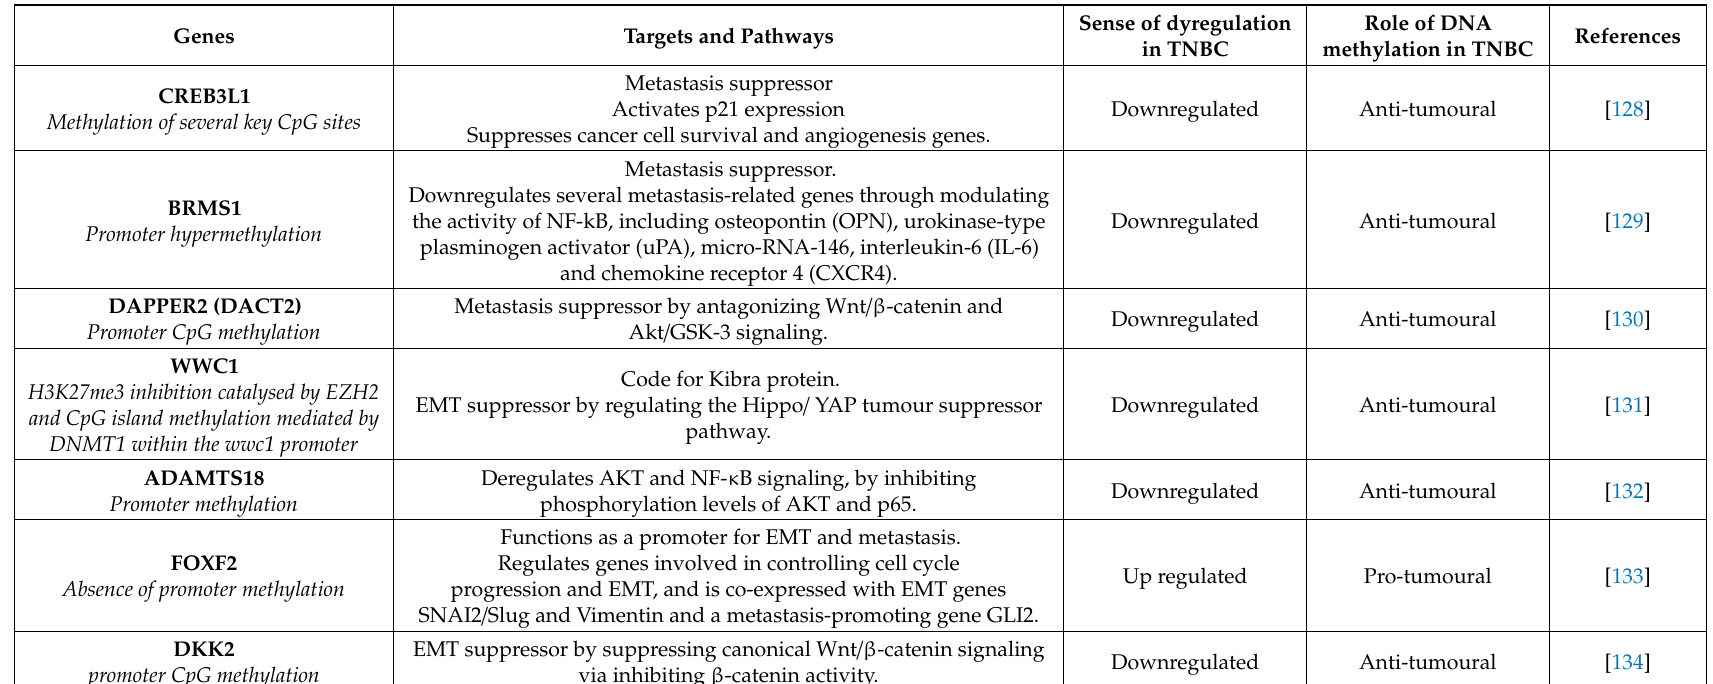
Table 5. DNA modifications implicated in the induction of